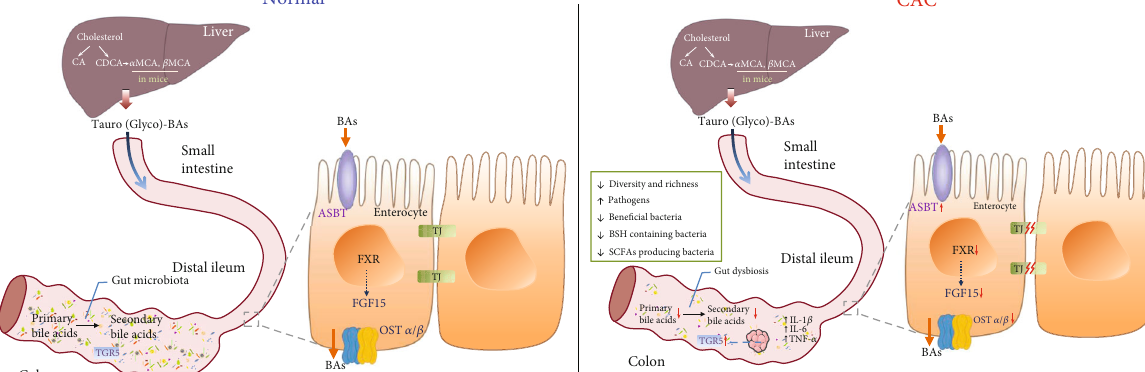
Figure 7: Gut dysbiosis and abnormal bile acid metabolism in colitis-associated cancer. Synthesized in the liver, bile acids are transported to the intestine in the form of conjugated bile acids. In the distal ileum, most of them are reabsorbed and conveyed to the liver in the presence of the FXR-FGF15 axis and bile acid transport receptors. In the colon, the gut microbiota promotes bile acid deconjugation and the conversion of primary bile acids to secondary bile acids. After AOM/DSS treatment, the BSH containing bacteria is reduced. Thus, dysbiosis inhibits bile acid metabolism and induces decreased secondary bile acids. Considering the bile acid receptors, the expression of FXR-FGF15 axis, OST α , and OST β is decreased, while ASBT is increased, which limits the reabsorption of bile acids and leads to the accumulation of bile acids in enterocytes. The colon of the CAC model shows a severe in fl ammatory response, disrupted barrier function, and elevated expression of TGR5 in tumor tissues. BAs: bile acids; ASBT: apical sodium-dependent bile acid transporter; FXR: farnesoid X receptor; FGF15: fi broblast growth factor 15; TGR5: G-protein coupled receptor; OST α and OST β : organic solute transporter subunit α and β ; BSH: bile salt hydrolase; CAC: colitis-associated cancer; TJ: tight